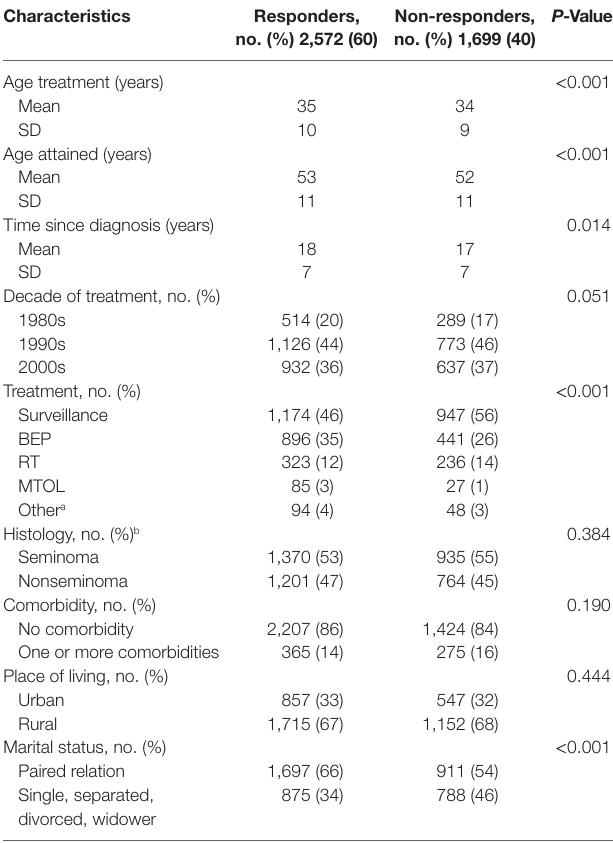
Table 1 | Characteristics of responders included in DaTeCa-LATE and non-responders.